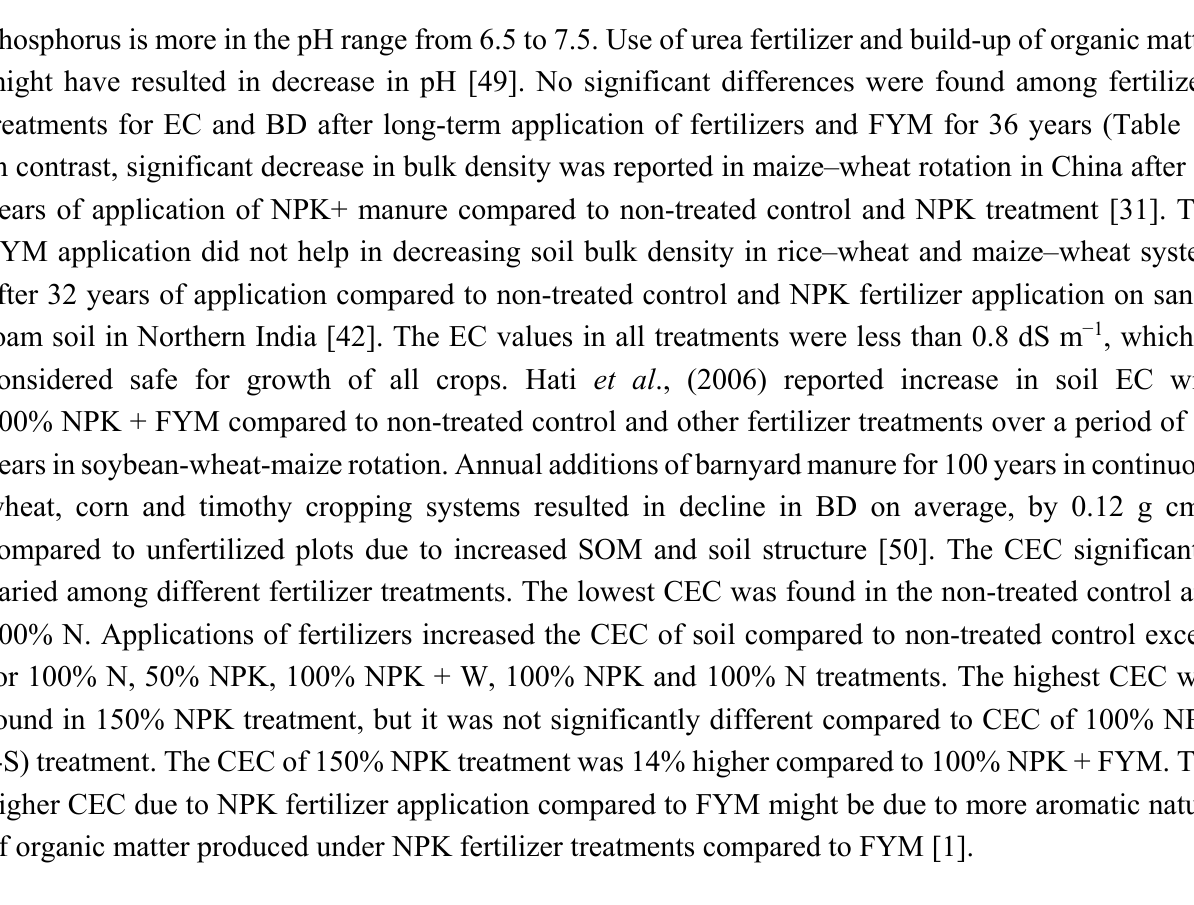
Table 1. Physical and chemical characteristics of the soil among different fertilizer treatments in